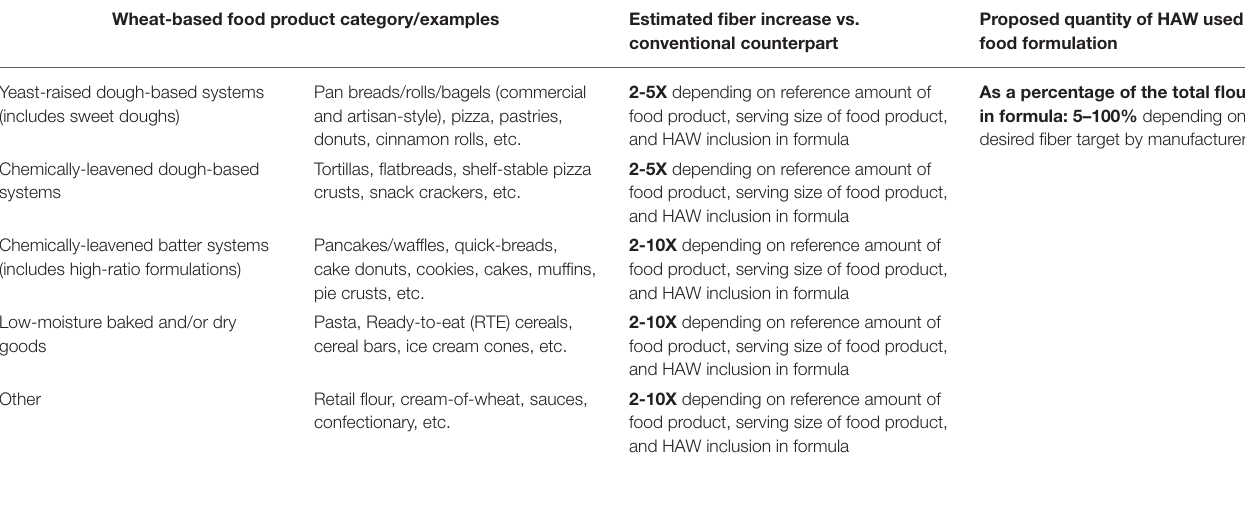
TABLE 1 | Potential wheat-based foods that can be made with HAW and the subsequent impact on their fiber level. Wheat-based food product